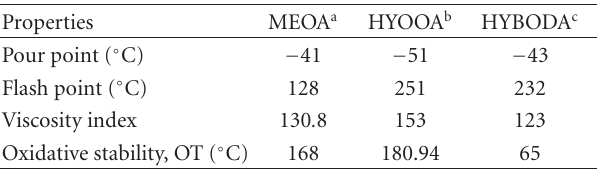
Table 8: Physicochemical properties of MEOA and HYOOA. Properties MEOA